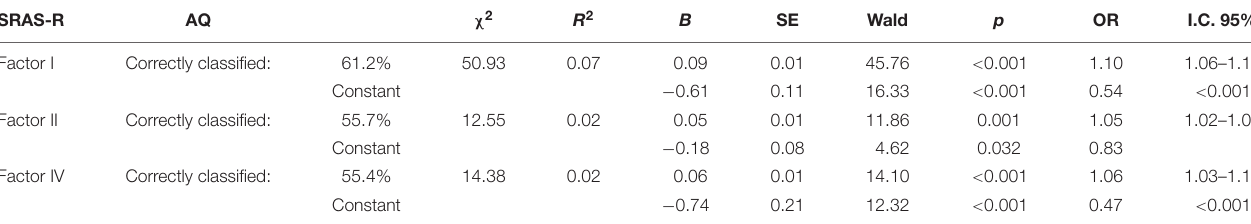
TABLE 6 | Logistic regression model for the probability of presenting high Physical Aggression based on the school refusal behavior.